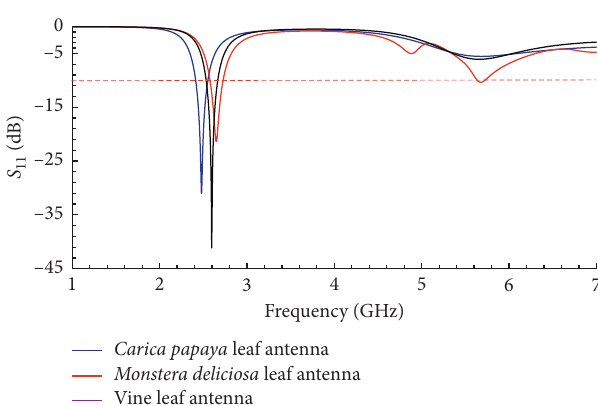
Figure 6: The S 11 of Slitless Defected-ground width BioAs-MPAs